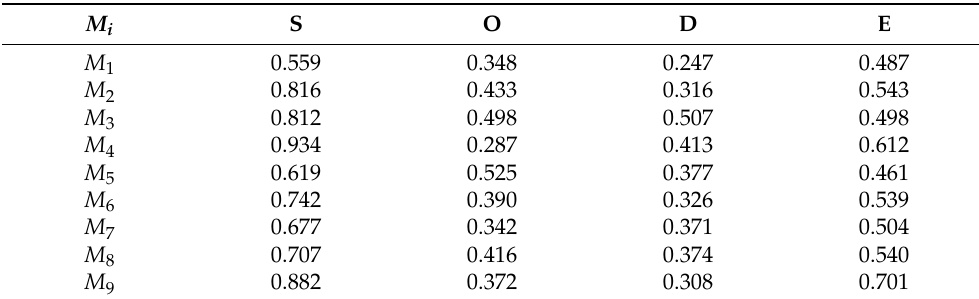
Table 8. The normalized matrix Y (modified technique for order preference by similarity to an ideal solution